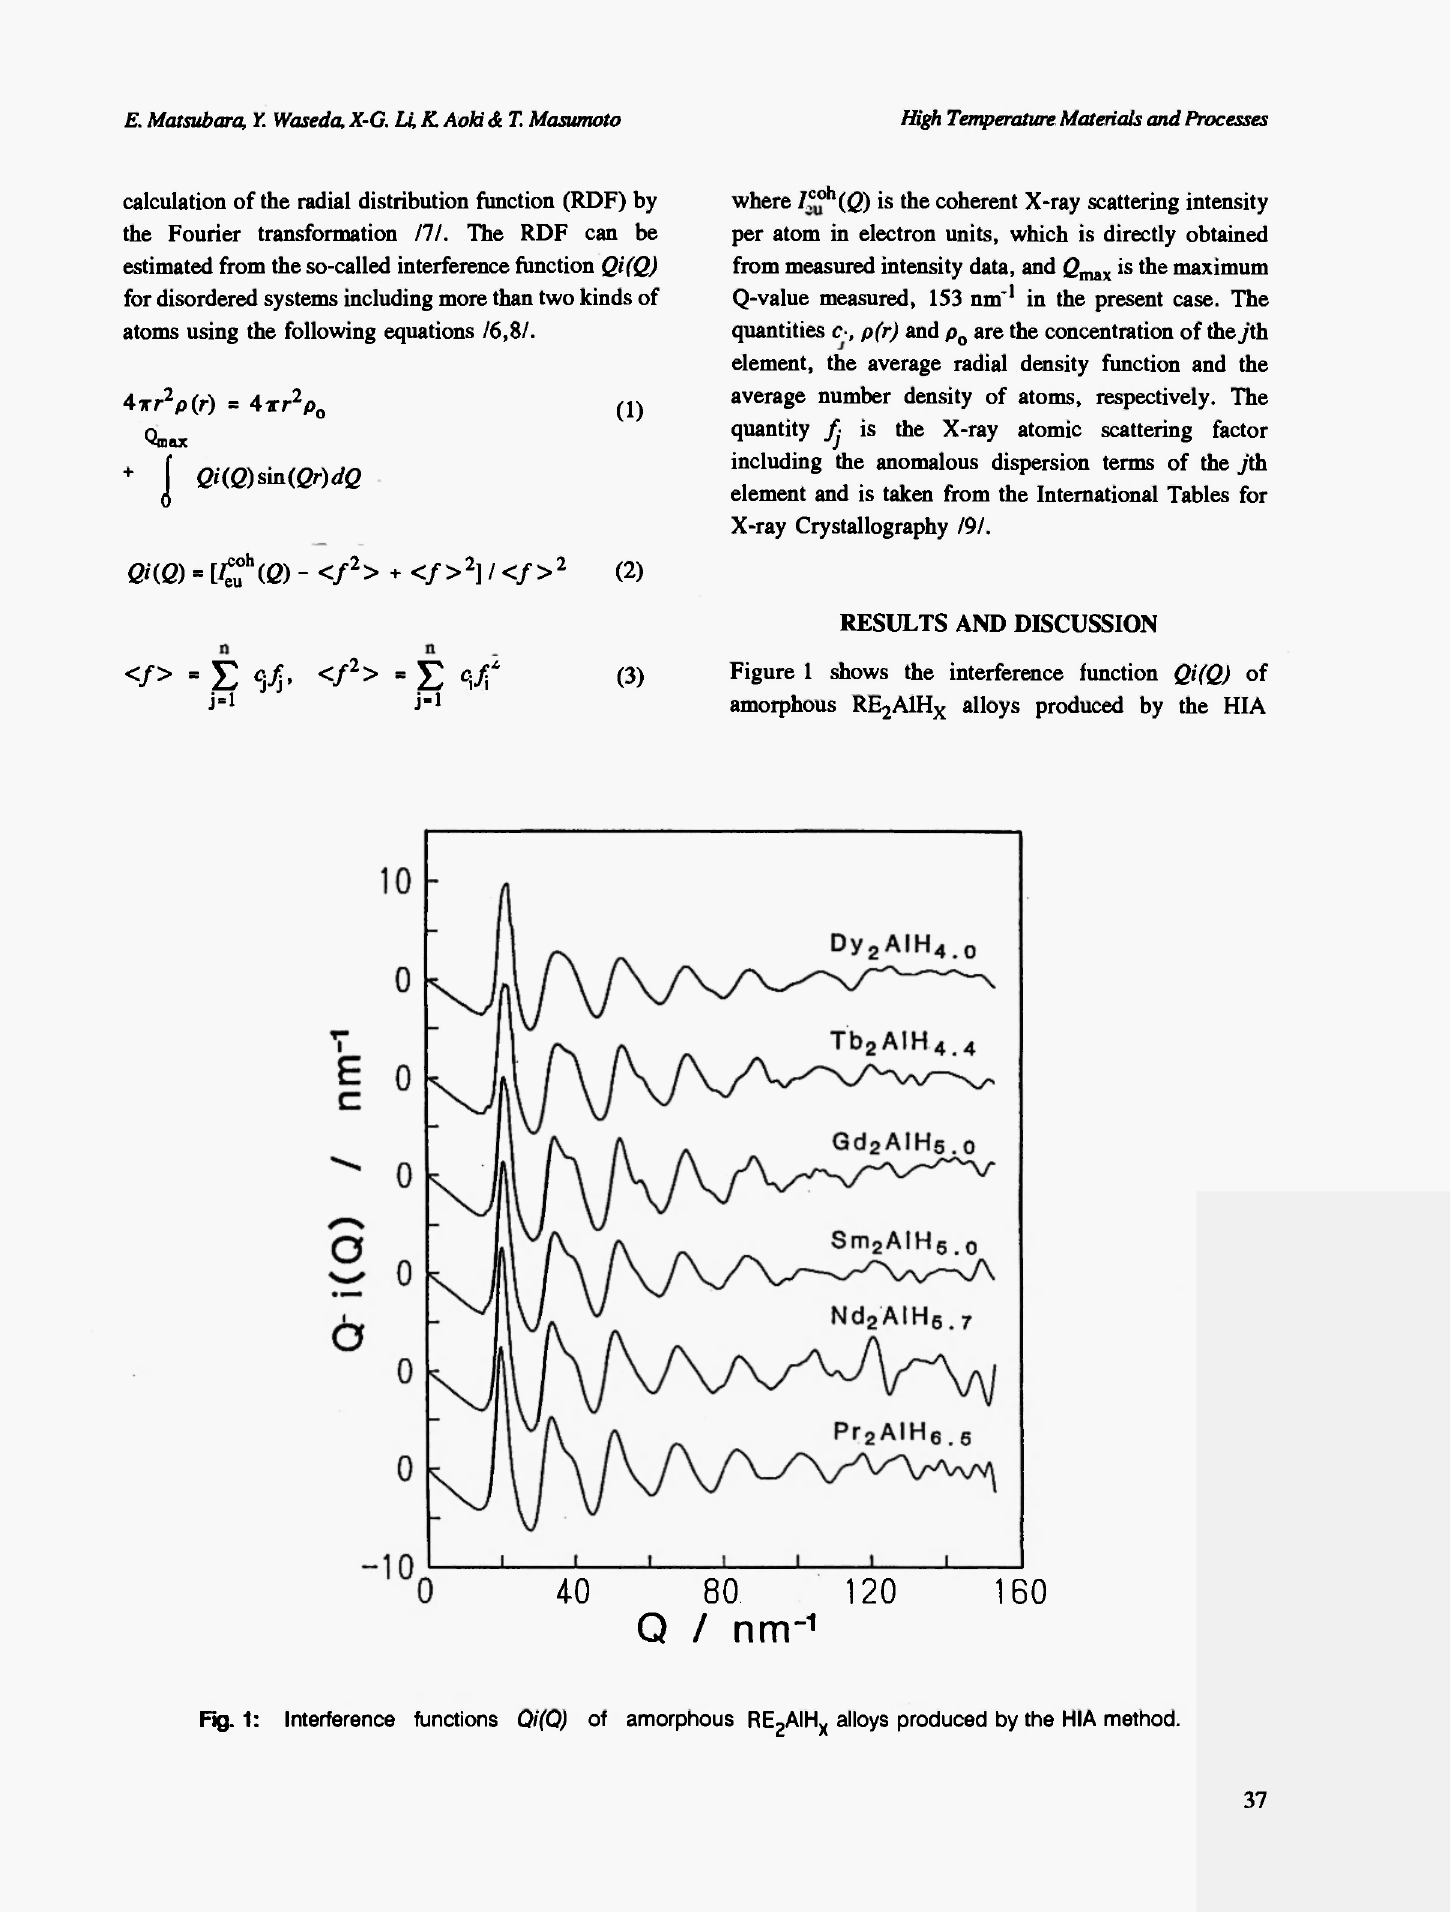
Fig. 1: Interference functions Qi(O) of amorphous RE 2 AIH X alloys produced by the HIA